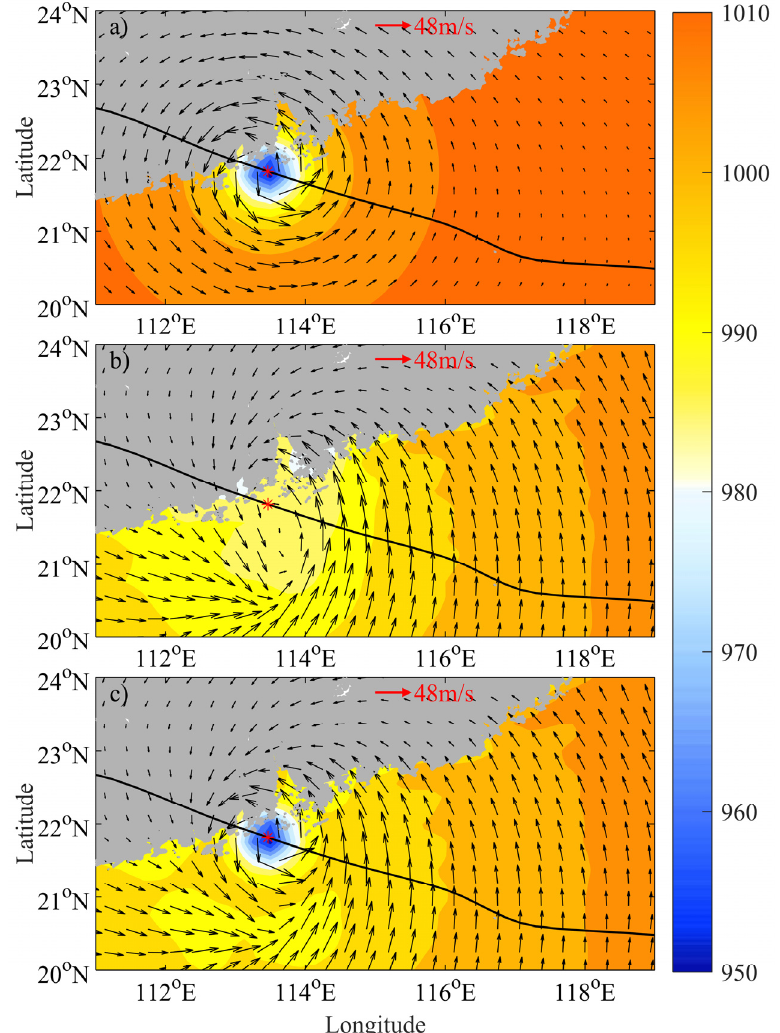
Figure 3. Planar views of Typhoon Hato (2017). ( a – c ) The black lines in Figures 3a–c show the path of 155 Hato. The red “*” in Figure 4a–c show the center position of Typhoon Hato at 04:00 UTC on 23 August Typhoon Hato. The red “ * ” in Figures 4a–c show the center position of Typhoon Hato at 04:00 UTC 156 2017. Wind velocity (units: m / s; vectors) and air pressure (units: hPa; shaded) provided by Holland on August 23, 2017. Wind velocity (units: m/s; vectors) and air pressure (units: hPa; shaded) 157 model ( a ), CFSV2 ( b ), and assimilation typhoon model ( c ) at 04:00 UTC on 23 August provided by Holland model (Figure 3a), CFSV2 (Figure 3b), and assimilation typhoon model (Figure 158 3c) at 04:00 UTC on August 23, 2017. 159